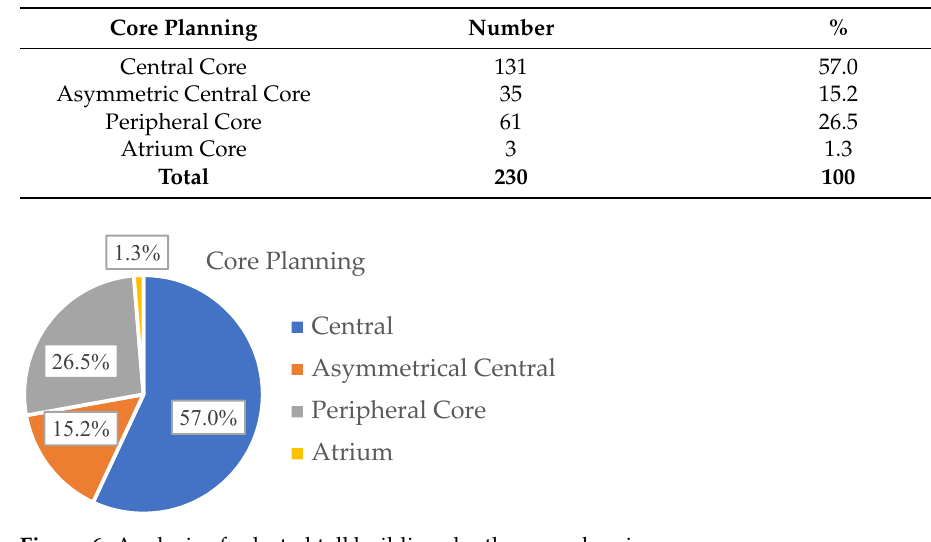
Figure 6. Analysis of selected tall buildings by the core planning.